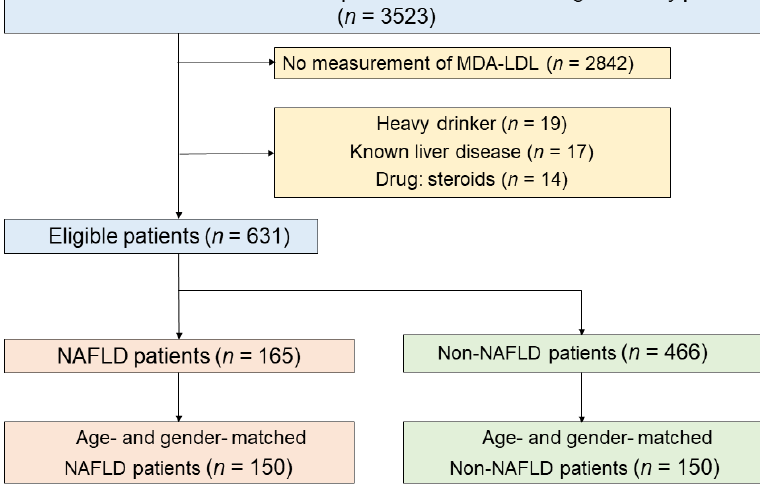
Figure 1. Flow diagram of the study.